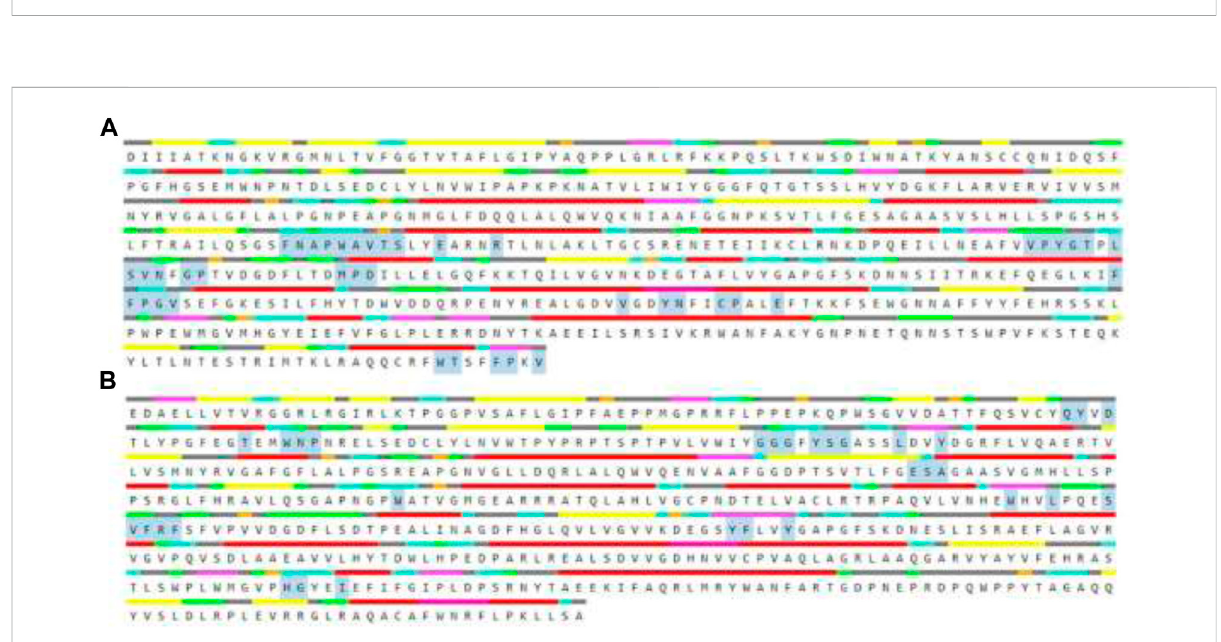
FIGURE 6 (A) Acetylcholinesterase (AChE) and (B) Butyrylcholinesterase (BChE) activity of AC-HANPs, AC extract and Tacrine as positive control in grey, yellow and orange